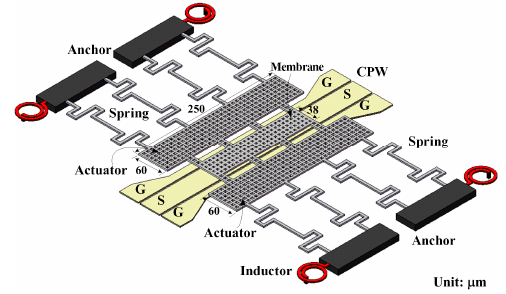
Figure 1. Structure of the micromachined switch. CPW: Coplanar waveguide; G: Ground; S: Signal.